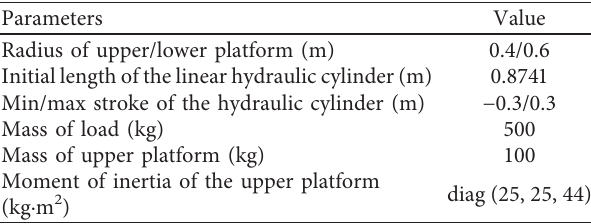
Figure 4. The first is a signal generator block used to generate a target trajectory. The second is the kinematics block and its main function is to convert the task space signal to the joint space signal and calculate the speed Jacobian matrix. The third is the PID controller block. The fourth is the hydraulic system block. The fifth is the mechanical model of the Stewart parallel mechanism. The sixth is the EKF estimator.